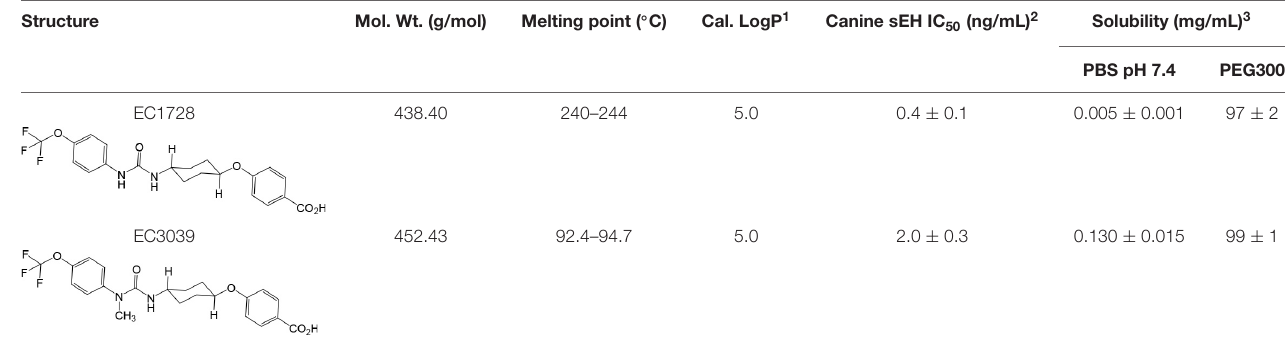
TABLE 1 | EC1728 and EC3039 are potent sEH inhibitors.